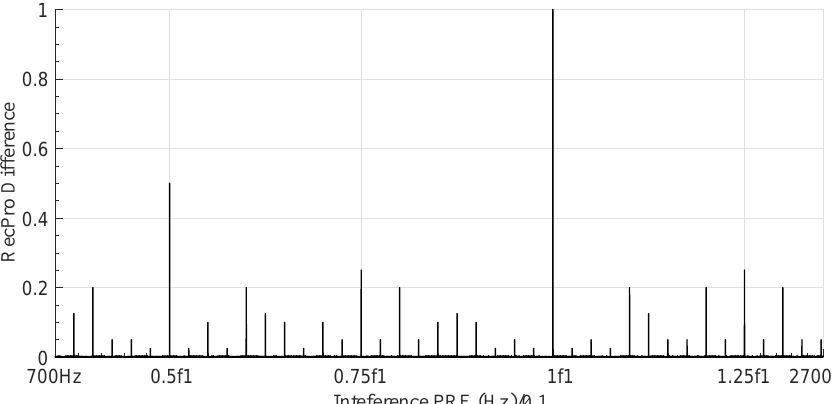
Figure 8. The maximum variation of recognition probability vs Pulse Recurrence Frequency (PRF).